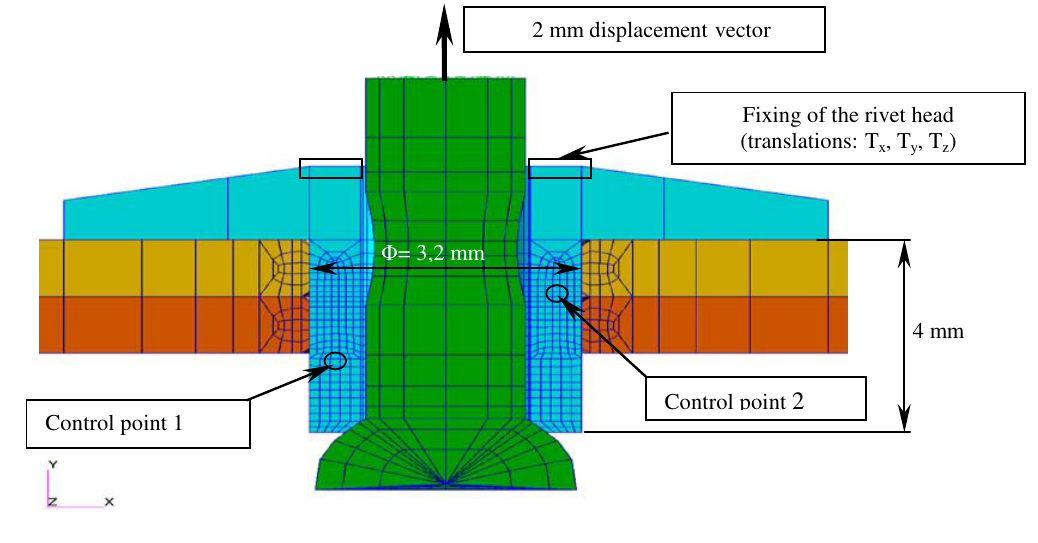
Fig 2. Model of the joint with defined load and boundary conditions for the riveting process